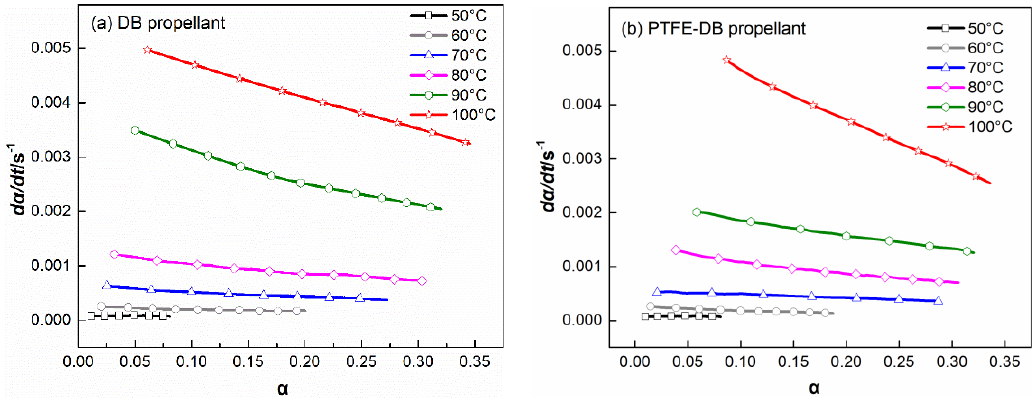
Figure 5. Differential conversion vs. conversion curves of DB propellant ( a ) and PTFE-DB propellant ( b ) at different temperatures.